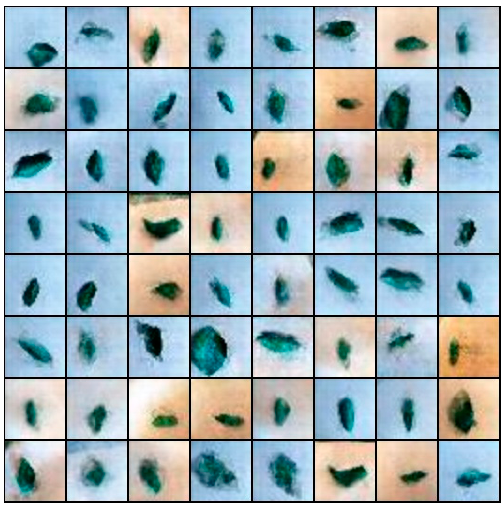
Figure A1. The complete citrus canker generated image. 997 training images, which were complete lesion leaf image generated using WGAN-GP after training for 100,000 iterations. Table A1. IS and FID of the complete lesion leaf image generated by DCGAN, WGAN-GP, self- supervised GAN and improved self-supervised GAN for 997 training images after training for 100,000 iterations. We gathered statistics for 10 exercises, and the difference was statistically significant ( p < 0.05).